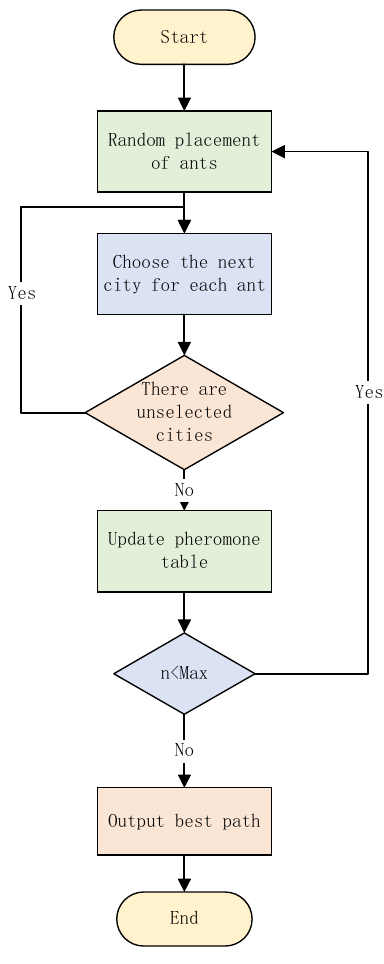
Figure 3. The flow chart of the ant colony optimization algorithm. The probabilistic search formula for the ant colony is delineated